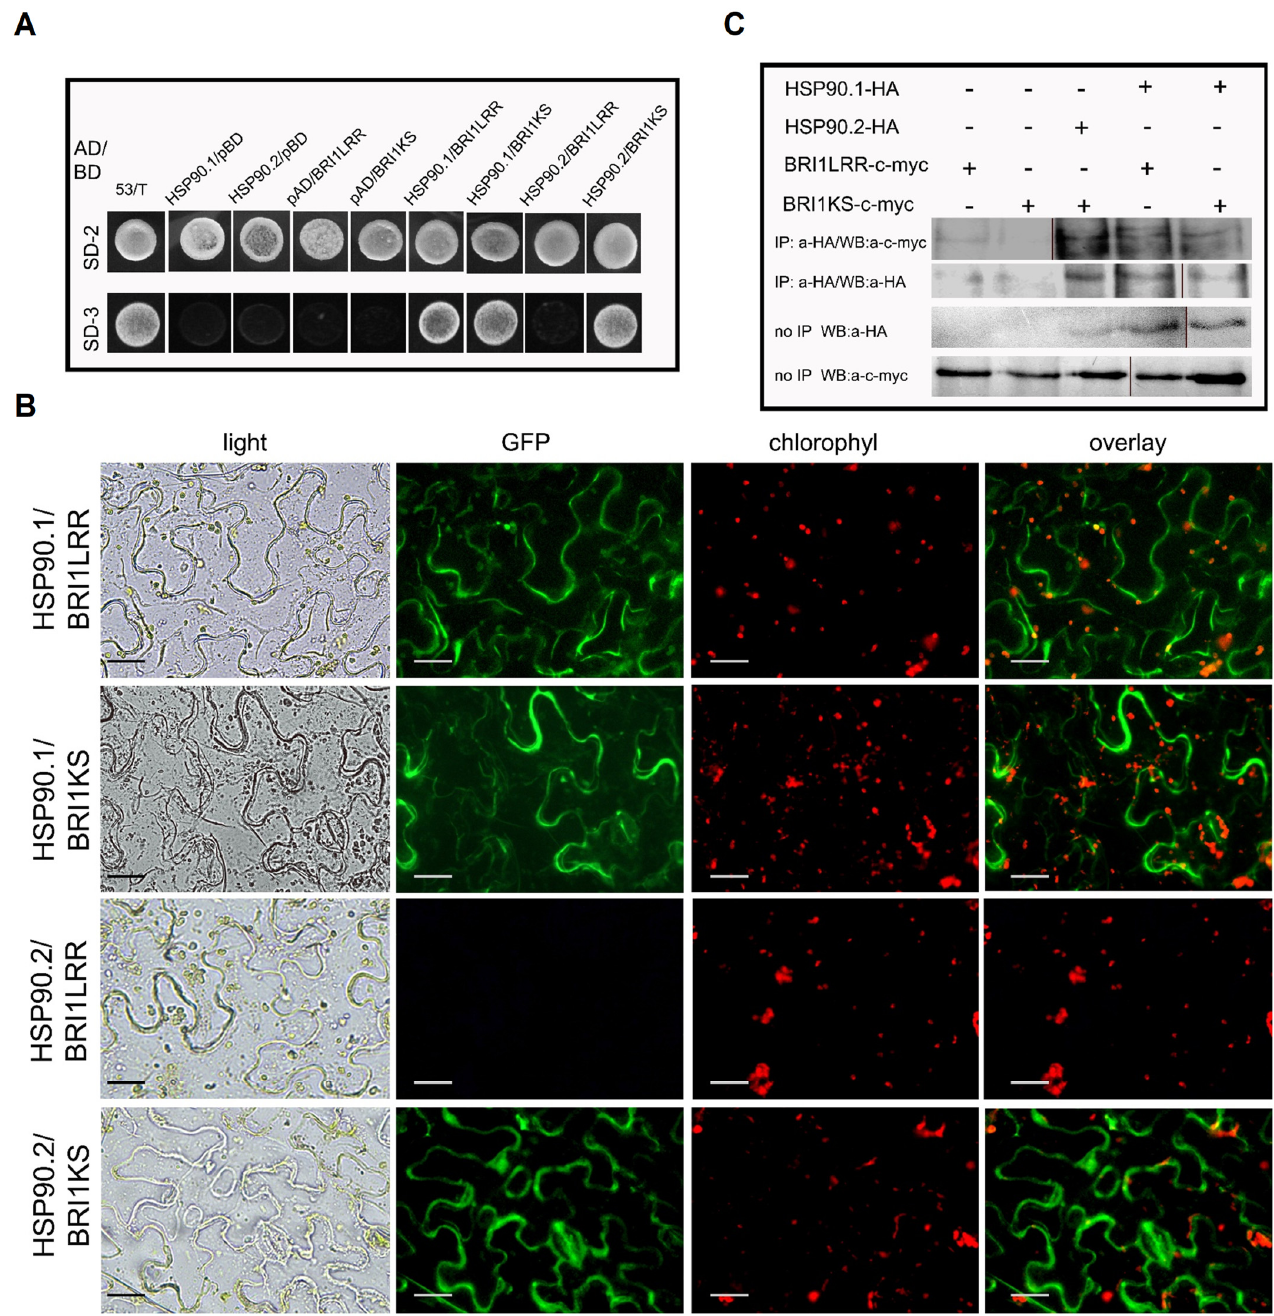
Figure 2. HSP90.1 and HSP90.2 interact with BRI1 receptor domains in vivo and in vitro. ( A ) Yeast two-hybrid assays using BRI1LRR and BRI1KS as baits and HSPSP90.1 or HSP90.2 as preys. Upper column, co-transformants grown on SD -Leu-Trp medium (SD-2) demonstrate that both bait and prey plasmids are present in yeast cells. Positive selection of yeast two-hybrid interactions with minimal selection on SD -Leu-Trp-His medium (SD-3). ( B ) Interactions between HSP90s and BRI1LRR or BRI1KS domains by BiFC assays in tobacco epidermis. Interaction was detected between HSP90.1 and BRI1LRR or BRI1KS, and between HSP90.2 and BRI1KS. Scale bars, 20 µ m. ( C ) Co-immunoprecipitation assays of HSP90.1 with BRI1LRR and BRI1KS and HSP90.2 with BRI1KS. The co-immunoprecipitated proteins were detected by anti-c-Myc or anti-HA.